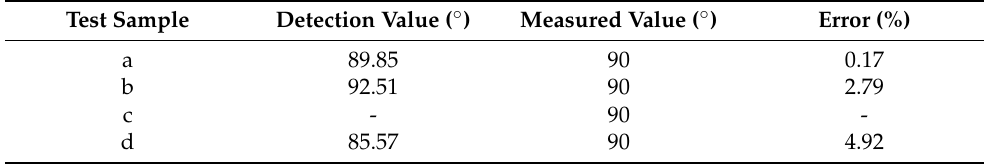
Figure 11. Identification results of loose bolts under different light conditions: ( a ) normal light; ( b ) weak light; ( c ) dark light; ( d ) camera flash. Table 7. Experimental data analysis of bolt loosening under different light conditions.